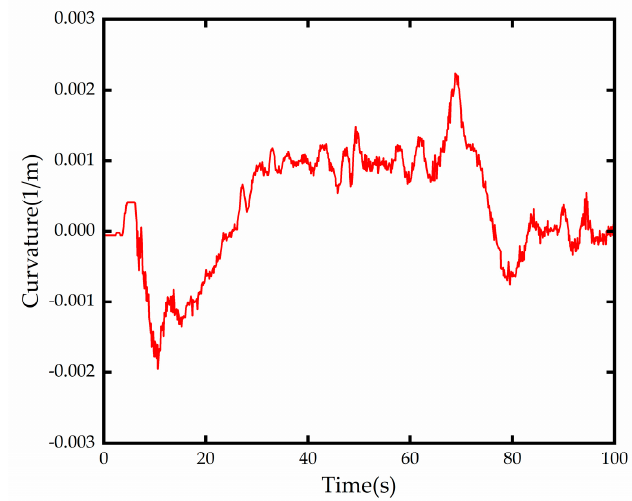
Figure 13. Satellite view of vehicle test road.